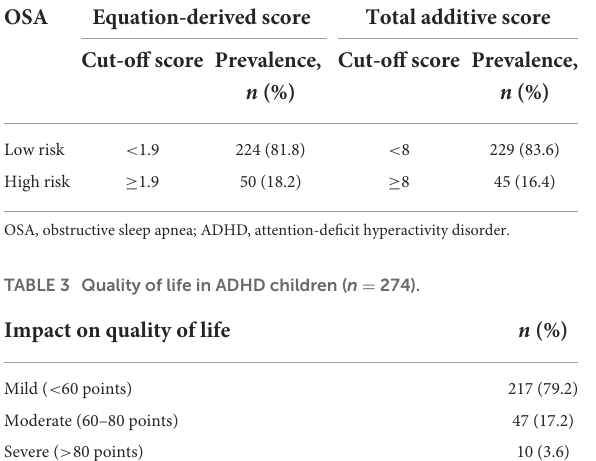
TABLE 2 Prevalence of high-risk OSA in ADHD children ( n = 274).